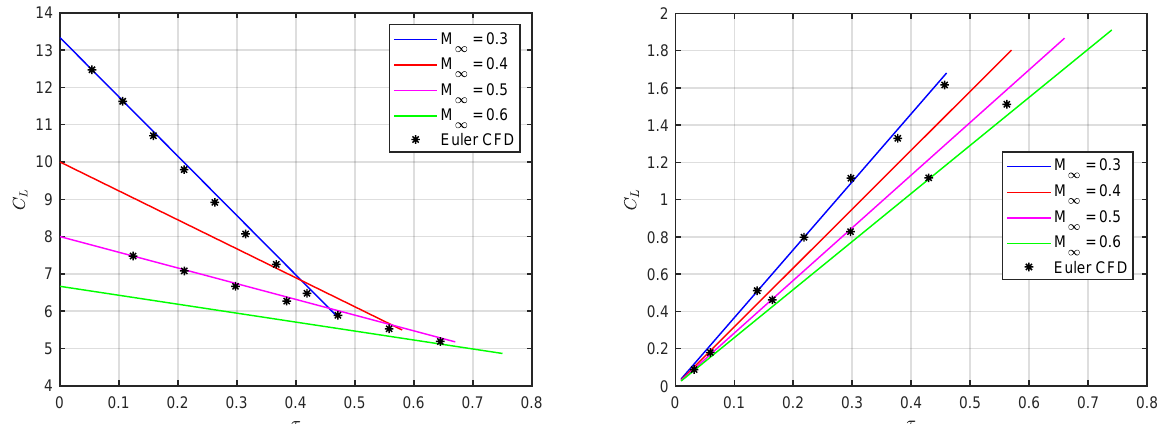
Figure 12. The incipient indicial lift for rectangular straight wing in compressible flow: AOA ( left ) and SEG ( right ), with η = 8 and Λ = 0 ◦